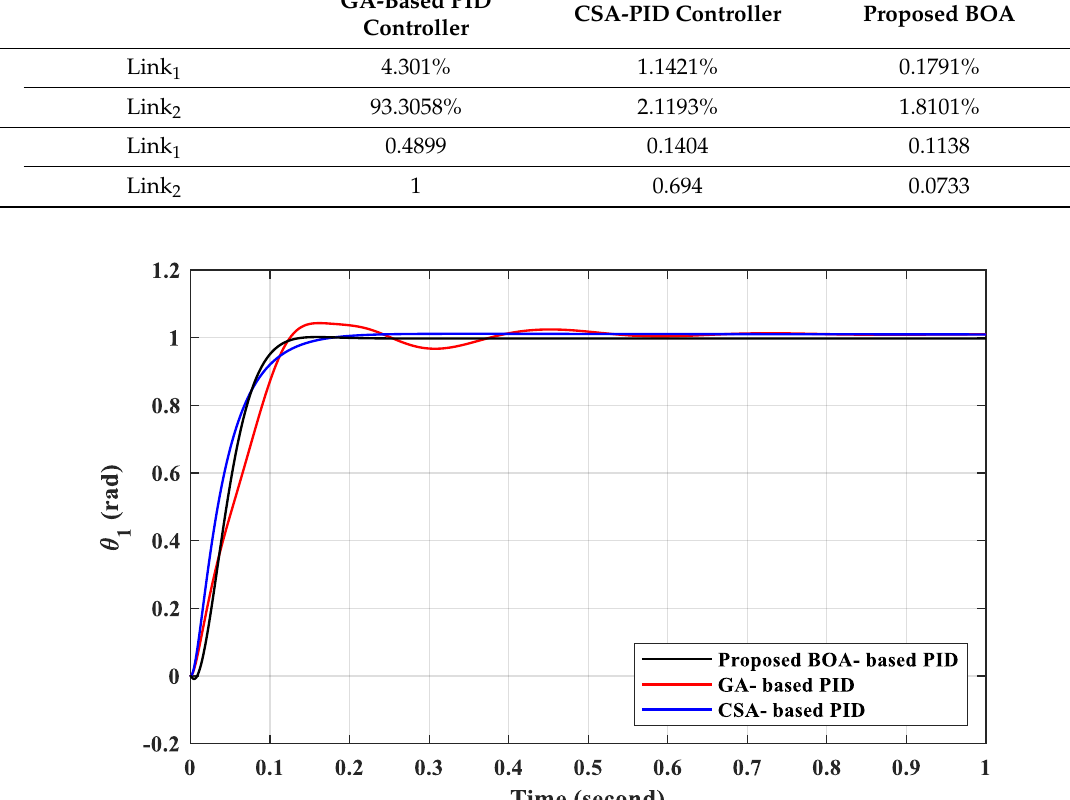
Figure 4. The convergence curve of the proposed BOA.